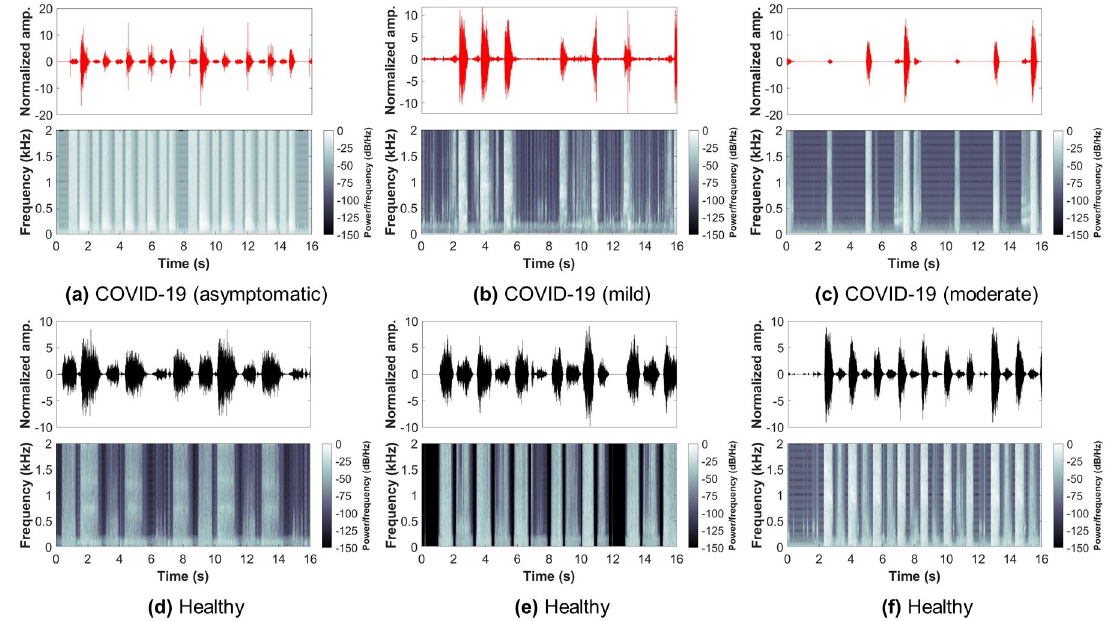
Fig 2. Examples from the shallow breathing sounds recorded via smartphone microphone along with their corresponding spectrograms. Showing: (a-c) COVID-19 subjects (asymptomatic, mild, moderate), (d-f) healthy subjects.